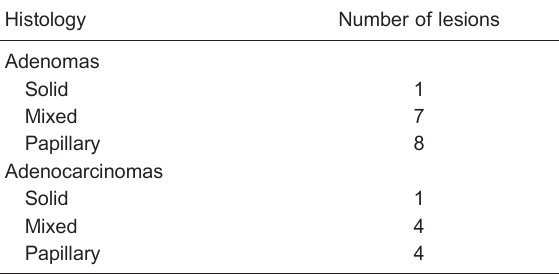
Table 1. Histology and number of randomly selected lung neoplastic lesions used to test for NR1I3 immunohistochemically.